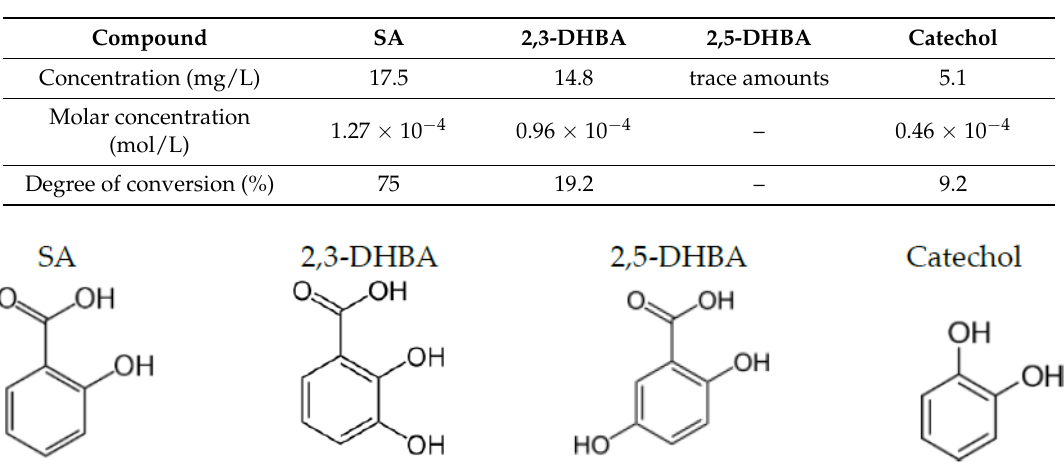
Figure 3. Structural formulas of salicylic acid and identified products of its oxidation.